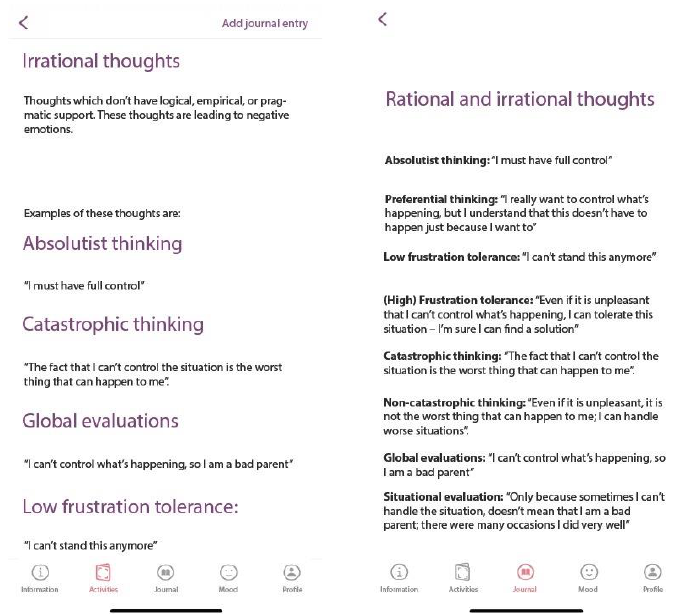
Figure 3. The Activities Section (Irrational beliefs).